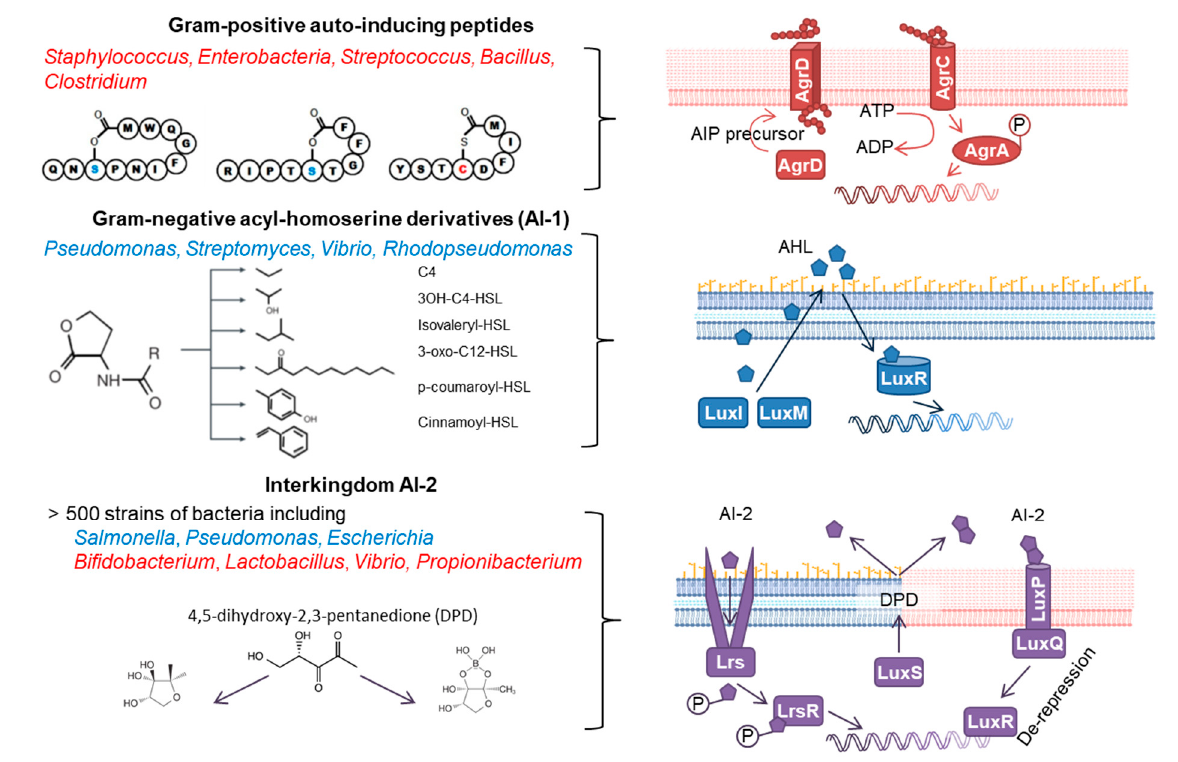
Figure 1. Schematic representation of the different quorum sensing molecules and intra-cellular signalling pathways Gram-positive (red) and Gram-negative (blue) bacteria. The QS molecule auto- inducer 2 (AI-2) has been described in both Gram-positive and Gram-negative bacteria (violet). Elements adapted by permission from [12], Springer Nature [13], and from BioRender.com (accessed on 2 November 2021).